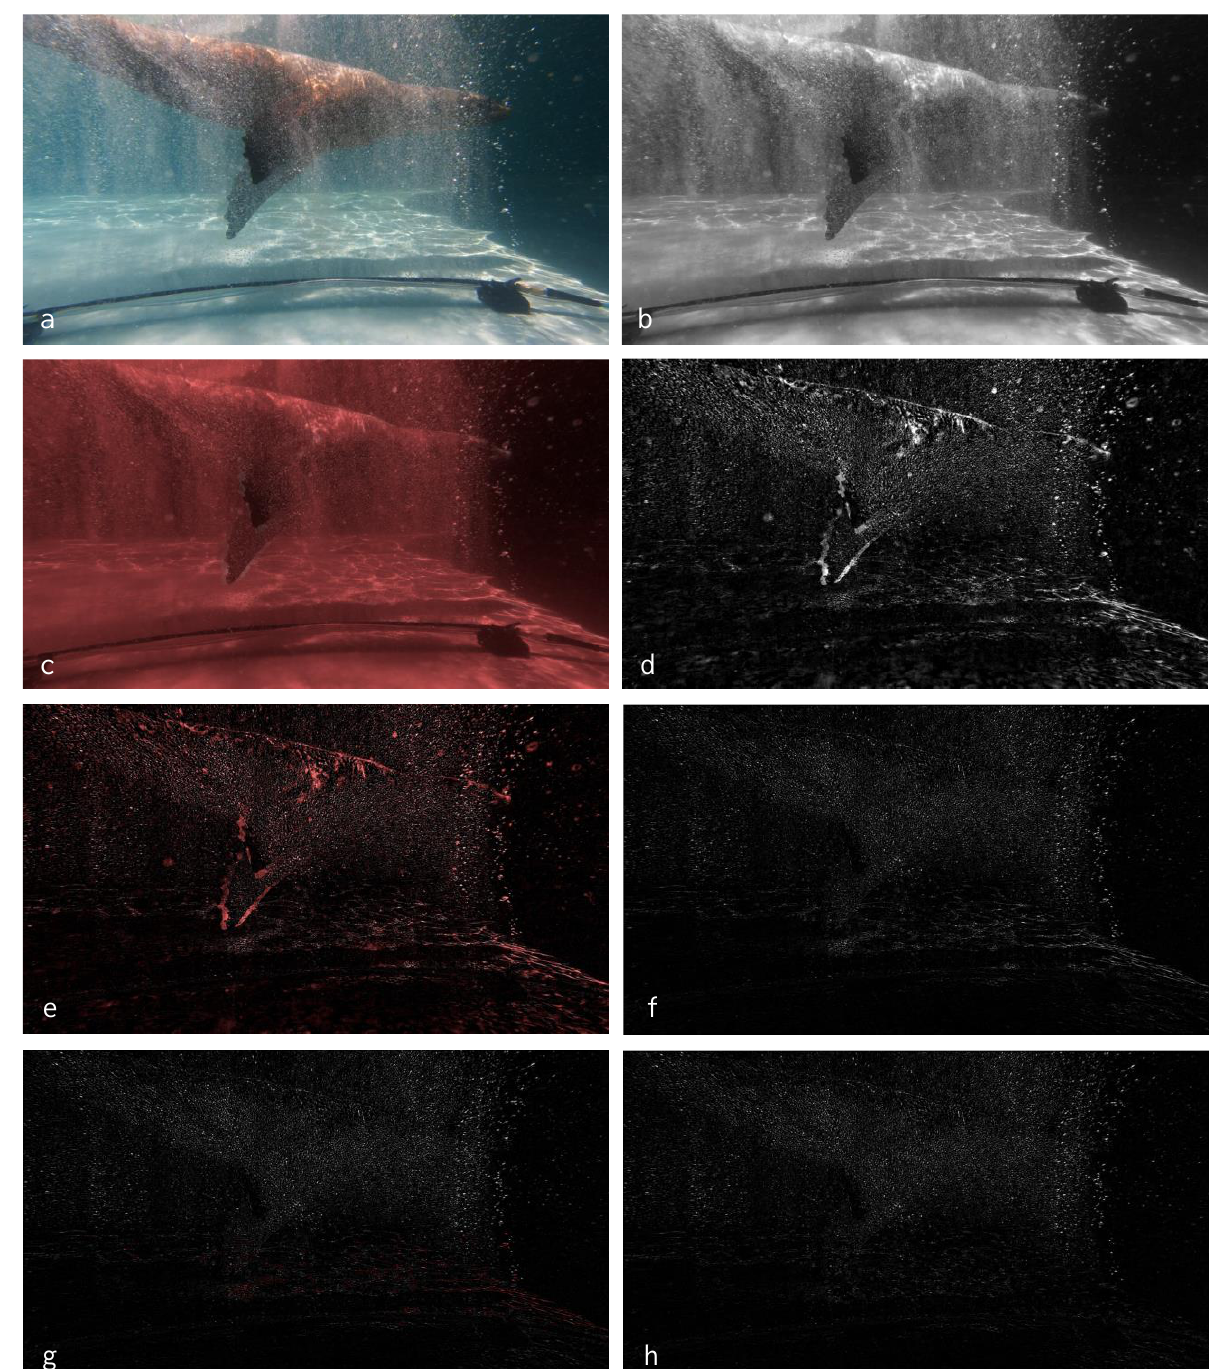
Figure 3. This figure shows the steps in image preprocessing and the changes that each step yields: ( a ) the raw data, ( b ) with only the red channel selected, ( c ) with the sliding minimum subtracted, ( d ) after a spatial median subtraction, ( e ) after a heuristic refinement, and, finally, ( f ) the preprocessed data that was used for velocity field calculations ( g ) is colored by the values to be subtracted ( h ) shows the result. This process is detailed in Section 2.2 and is necessary to calculate velocity fields from the in situ data.